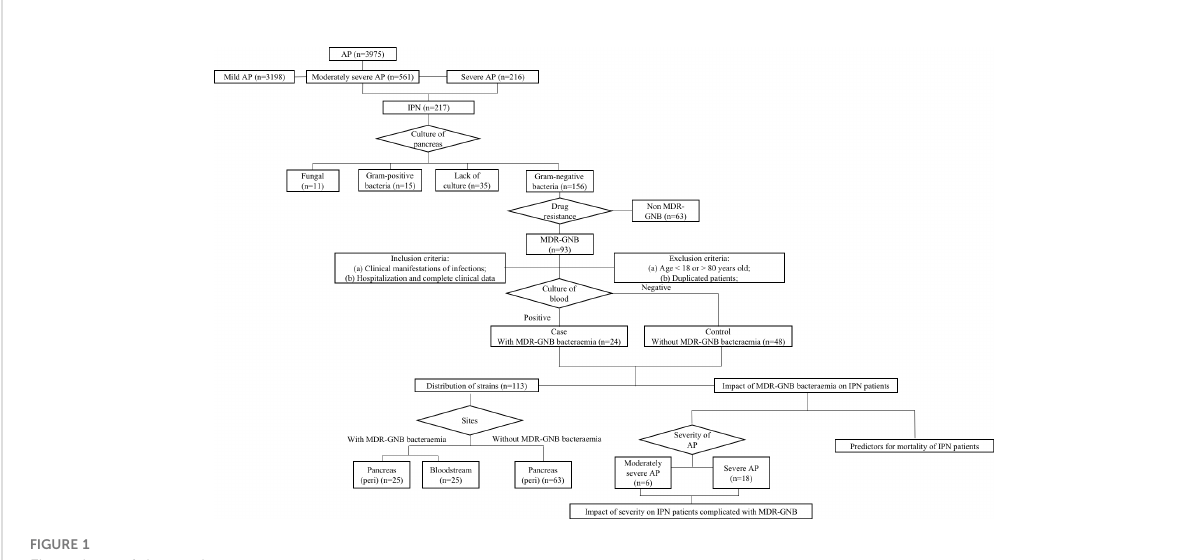
FIGURE 1 Flow chart of the